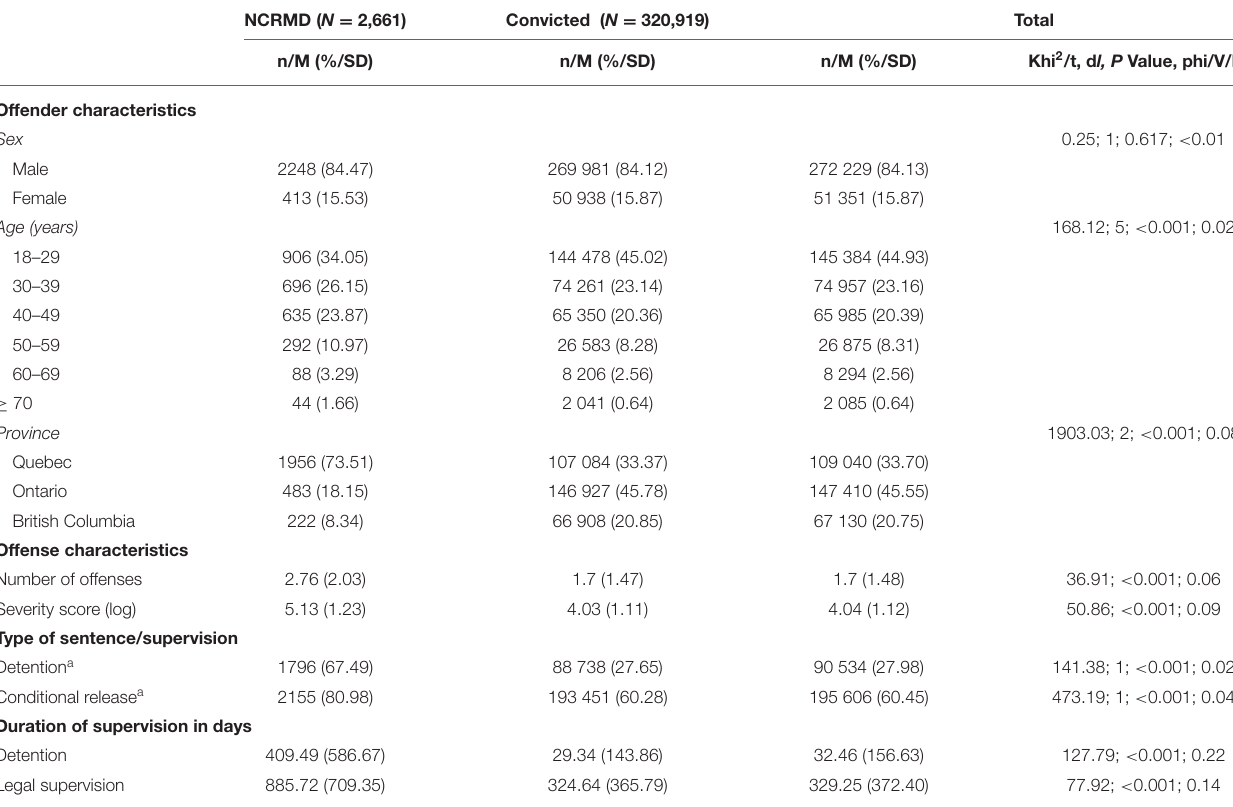
TABLE 1 | Descriptive characteristics of the